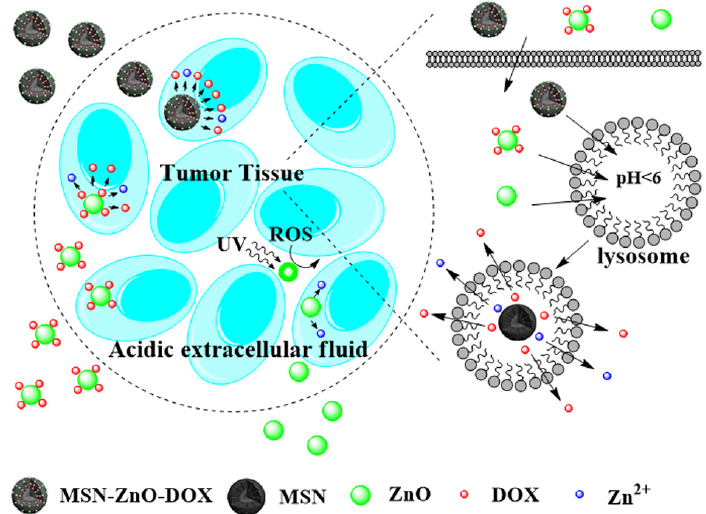
Figure 7. Schematic illustration of the DOX delivery from the ZnO